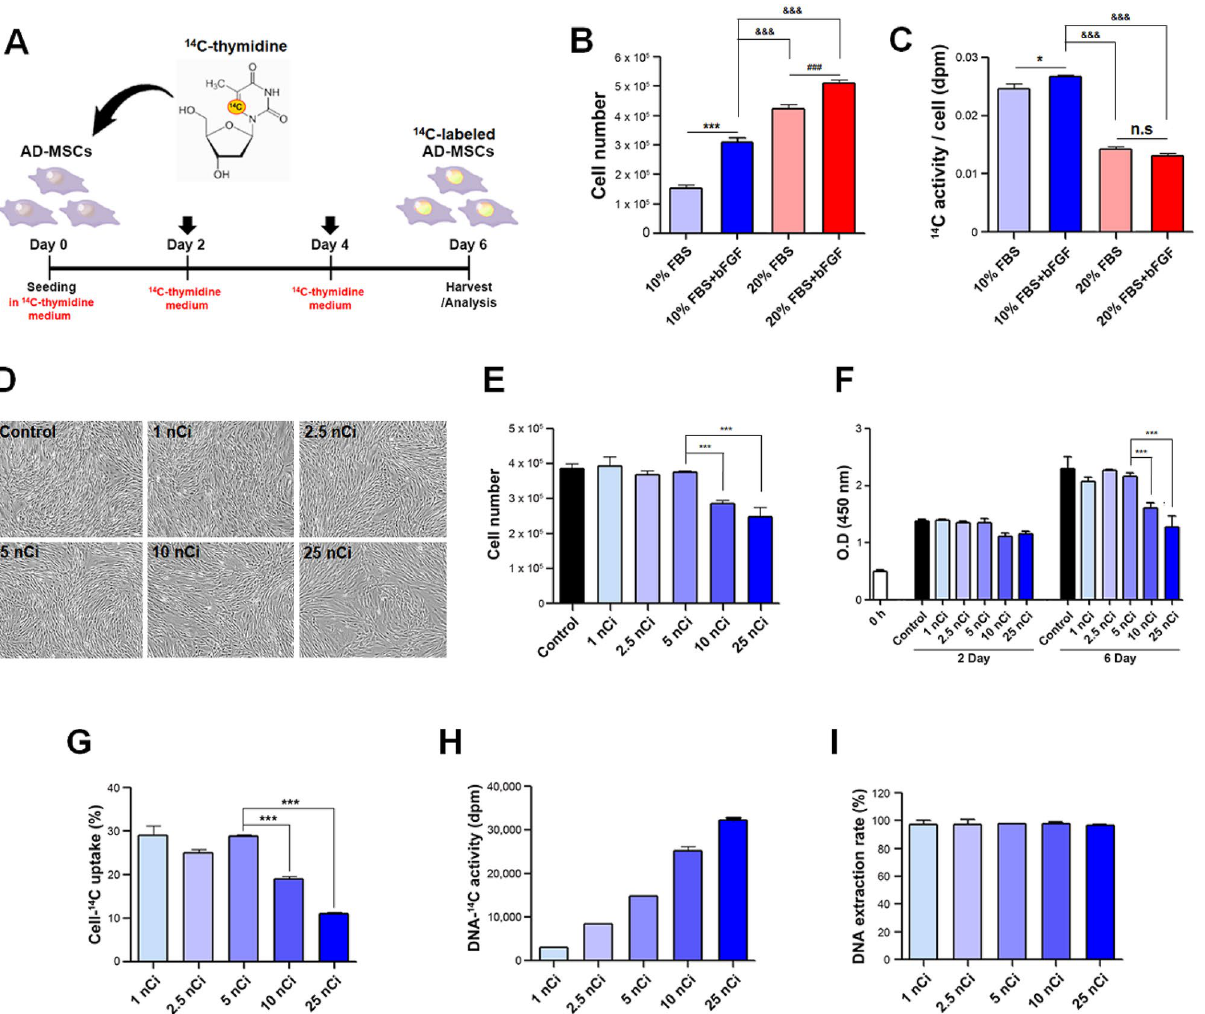
Figure 1. Optimization of 14 C thymidine concentration for AD-MSCs. ( A ) Method of labeling to prepare 14 C-labeled AD-MSCs. ( B ) Comparison of cell number by different culture medium condition. ( C ) Comparison of 14 C activity by different culture medium condition. ( D ) Image for identifying cell number and morphology change by different 14 C thymidine concentration. ( E ) Cell number comparison by different 14 C thymidine concentration using hemocytometer. ( F ) Comparison of cell proliferation by different 14 C thymidine concentration using CCK-8. ( G ) Comparison of uptake rate of AD-MSCs labeled with different concentration. ( H ) Measurement of radioactivity of DNA labeled with different 14 C thymidine concentration. ( I ) Comparison of extraction rate of DNA. ***p < 0.001 relative to the control or 5 nCi/ml, &&& p < 0.001 relative to the 10% FBS + bFGF group, ### p < 0.001 relative to the 20% FBS group. All data are expressed as mean ±